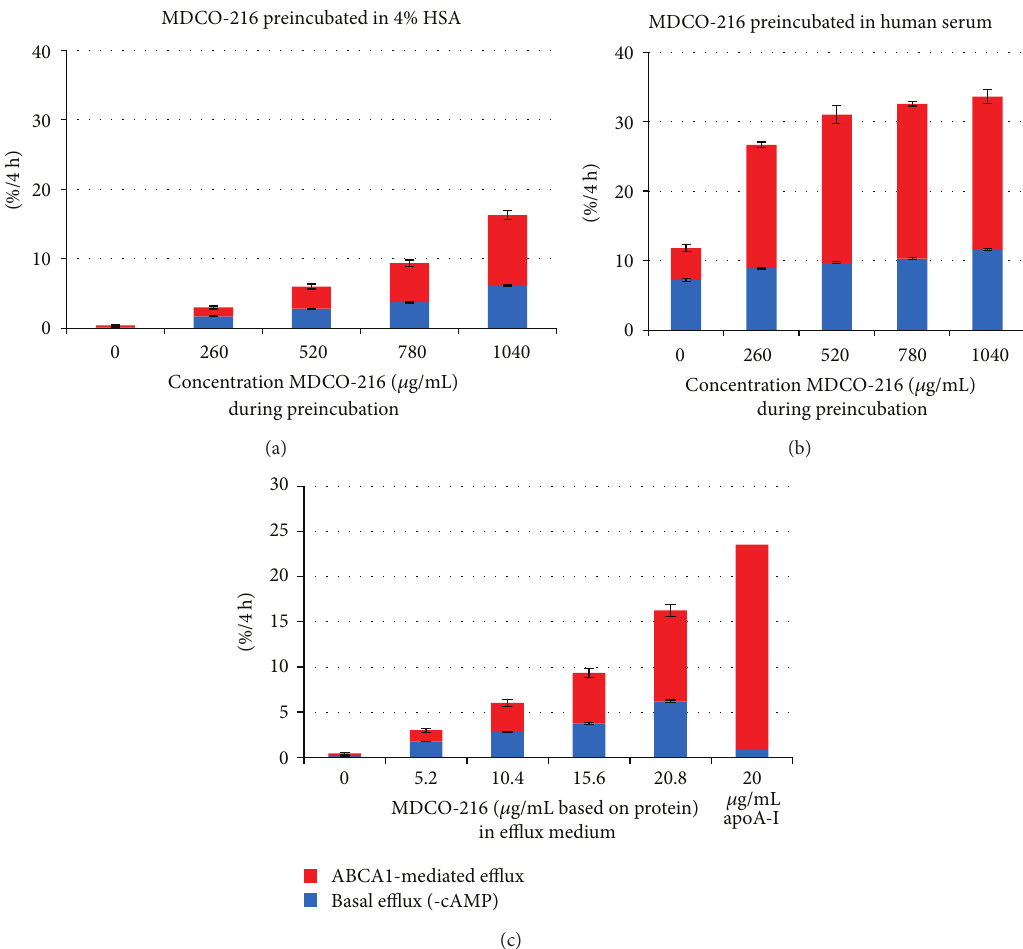
Figure1:(a)and(b)EffectofMDCO-216preincubatedwith4%HSA(a)orwithhumanserum(b)onglobalandABCA1-mediatedcholesterol efflux from J774 macrophages. Blue: basal efflux (efflux from cells not pretreated with cAMP), red bars: ABCA1-mediated efflux (additional efflux due to pretreatment of cells with cAMP). (c) The same data of (a) giving concentration of MDCO-216 (as protein) in the incubation medium of the efflux assay, compared with efflux induced by 20 𝜇 g/mL pure human wild-type apoA-I (uncomplexed) in the same